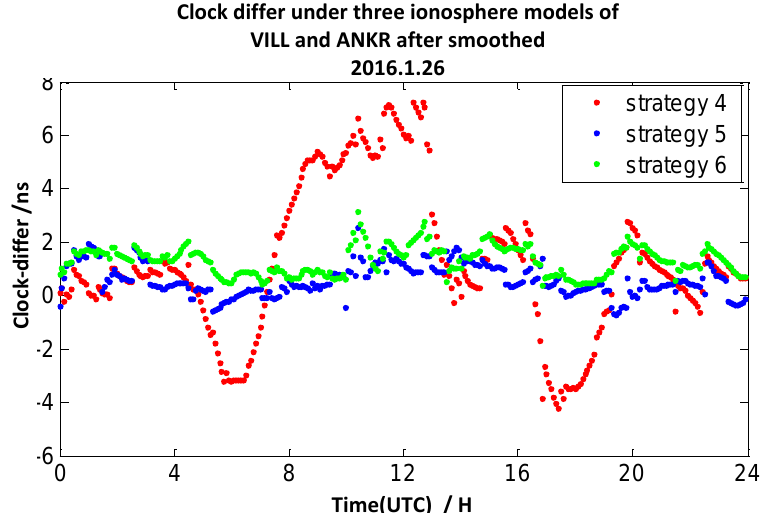
Figure 19. The clock difference under three ionosphere models of TLSE and WTZR after being smoothed.